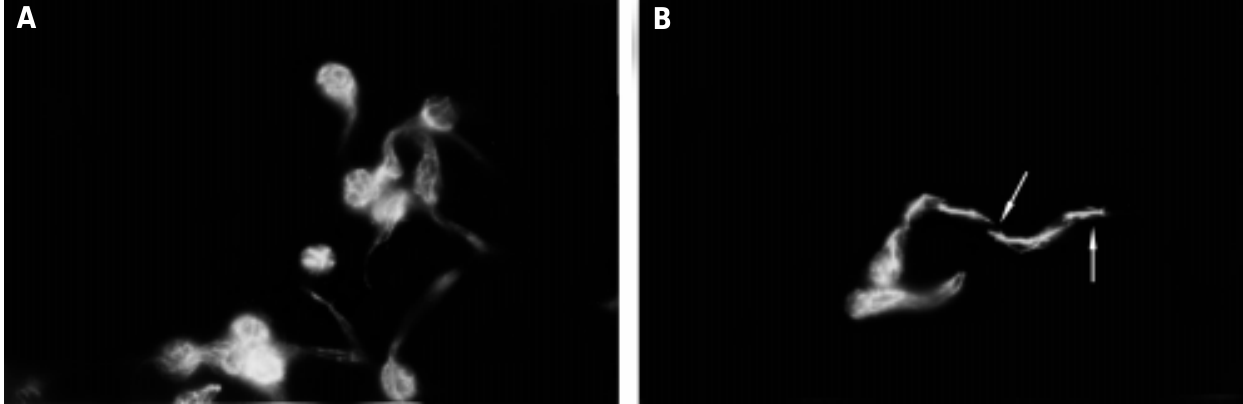
Table I - Percentage of long and short mitotic spindles in nud mutants and in the control strain R21 of Aspergillus nidulans . Strains Mitotic spindles (%) (relevant genotype) long short R21 48.25 51.75 XX3( nudA1 )* 20.54 79.46 AO1( nudC3 )* 17.95 82.05 XX20( nudF6 )* 19.27 80.73 SB05.10( nudG8 ) 37.50 62.50 *Significantly different from R21. P < 0.05 ( c 2 test).